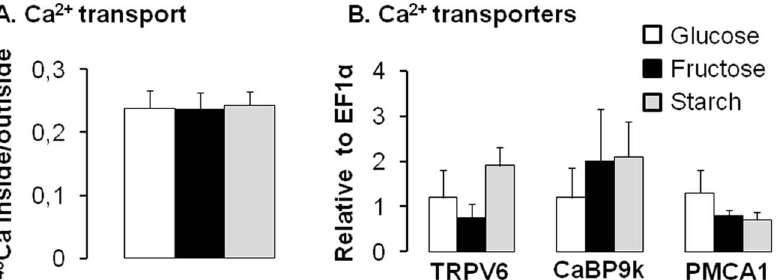
Figure 3. Chronic consumption of fructose has no significant effect on intestinal Ca 2 + transport rate and transporter mRNA expression in mice fed for three mo a high fructose, starch, or glucose diet containing normal Ca 2 + levels. (A) Active transduodenal Ca 2 + transport from the luminal to the basolateral compartment was expressed as a ratio of the final quantity of ( 45 Ca 2 + inside/ 45 Ca 2 + outside) of the everted sacs of mice fed diets containing 63% fructose, glucose or starch. (B) mRNA expression levels of intestinal Ca 2 + (TRPV6, CaBP9k, PMCA1) transporters. All expression data were analyzed by real-time PCR using EF1 a as a reference and normalized relative to levels seen in mice fed glucose diet. Data are means 6 SEM ( n =5 per group). Chronic consumption of high fructose levels has no significant effect on intestinal Ca 2 + transport rate and transporter mRNA expression.